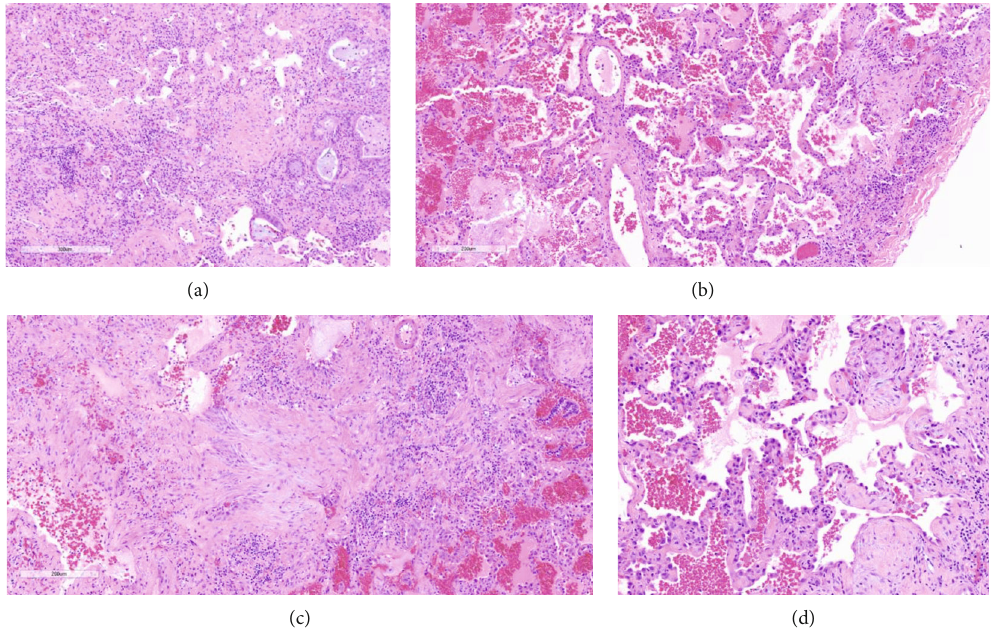
Figure 5: (a) Photomicrograph of the wedge biopsy from the lower lobe showing interstitial lymphocytic alveolar in fi ltrates and adjacent interstitial fi brosis and peribronchiolar metaplasia (hematoxylin and eosin 20x). (b) The lower lobe wedge biopsy also showed areas with mild, di ff use interstitial fi brosis characteristic of fi brotic nonspeci fi c interstitial pneumonia (NSIP) pattern of fi brosis (hematoxylin and eosin 20x). (c) The wedge biopsies showed only focal areas of organizing pneumonia with early intraalveolar fi brosis involving less than 10% of the tissues (hematoxylin and eosin 20x). (d) Foci of organizing pneumonia (hematoxylin and eosin 20x).